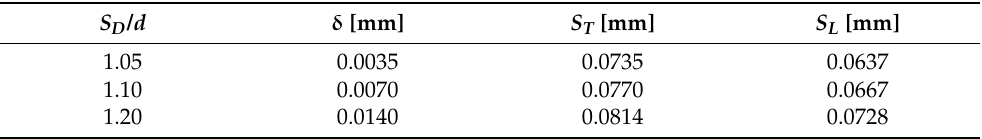
Table 1. Geometry parameters of the simulation